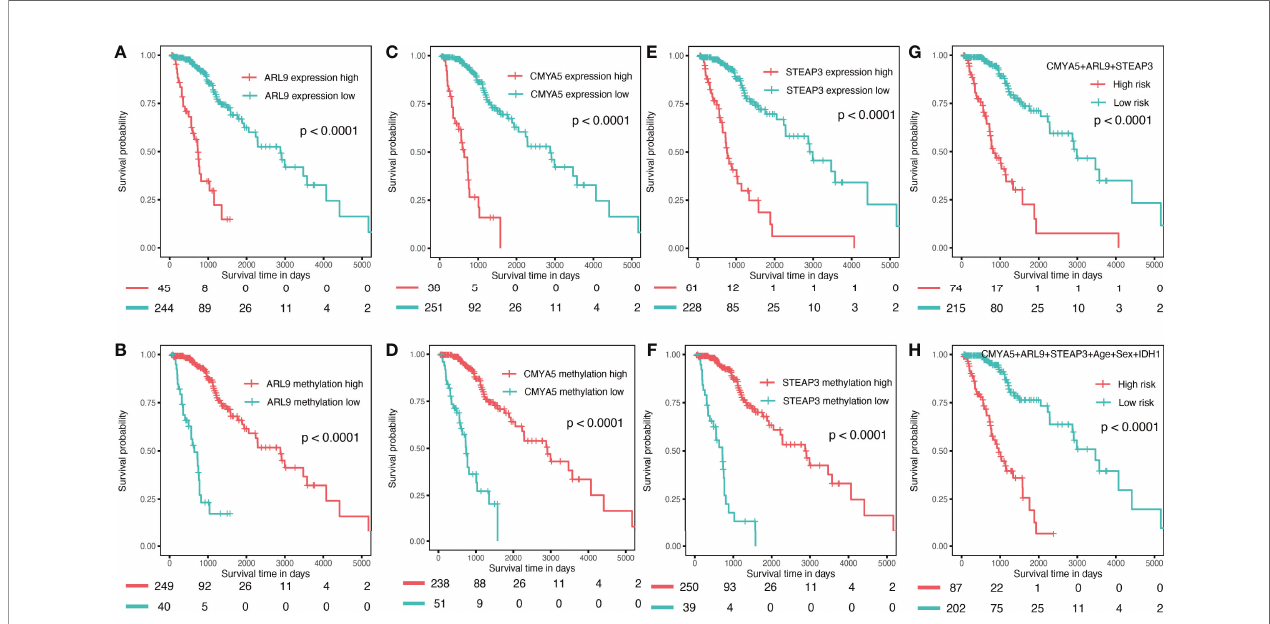
FIGURE 7 | Validation in the internal training set. (A – F) K – M OS curves for 3-gene expression and methylation in the internal training set. (G) combination of 3 genes. (H) of the nomogram.